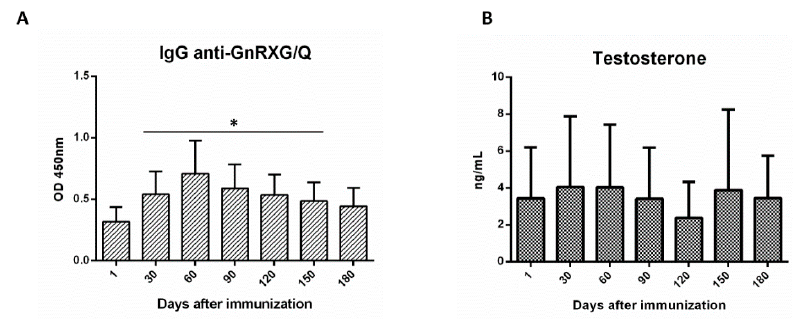
Figure 3. Vaccination induced the production of the specific IgG anti GnRXG/Q but did not decrease serum testosterone in field conditions. Dogs ( n = 32) were immunized on days 1 and 30 with GnRXG/Q antigen and chitosan as adjuvant. Vaccination induces specific IgG anti GnRXG/Q from day 30 to day 150 of the study ( A ). No significant differences in testosterone production were observed throughout the study ( B ). Production of serum IgG against the GnRxG/Q antigen was determined by indirect ELISA and serum testosterone by chemiluminescence. All data are represented as mean ± SEM. Asterisks (*) indicate significant differences in relation to day 0 ( p < 0.05).